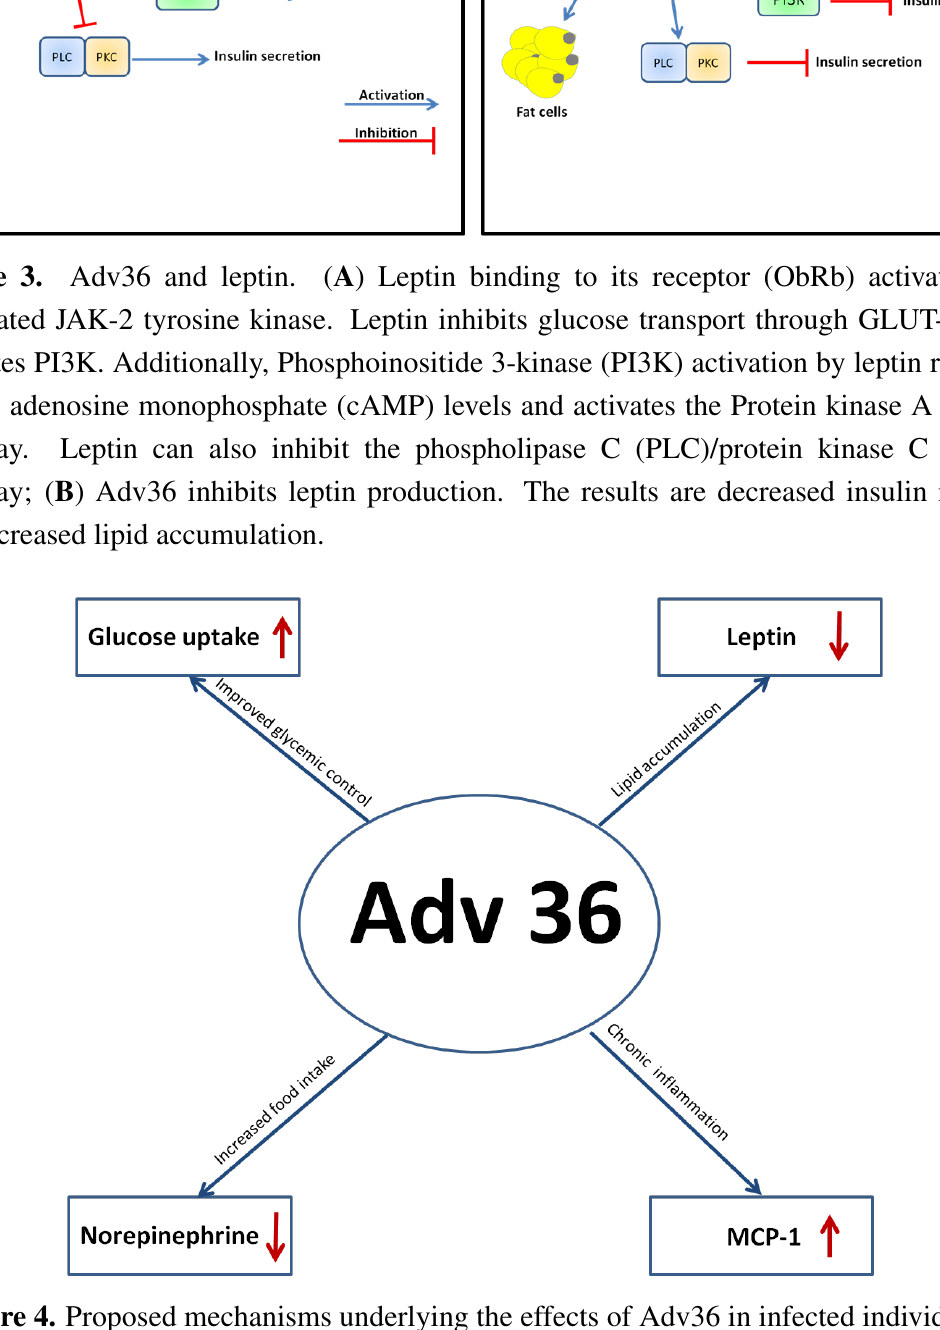
Figure 4. Proposed mechanisms underlying the effects of Adv36 in infected individuals.